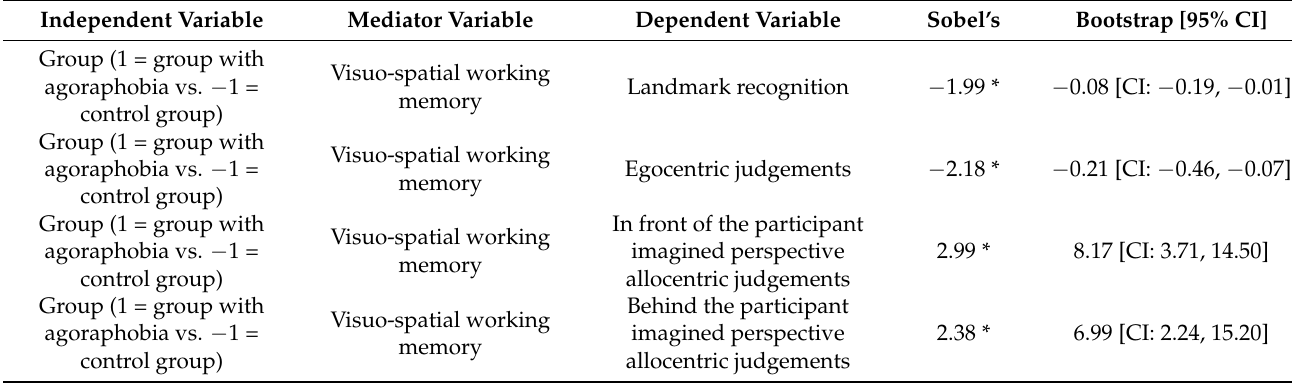
Table 1. Mediation analysis was carried out using the Preacher–Hayes bootstrapping method (Preacher and Hayes, 2004). Independent Variable Mediator Variable Dependent Variable Sobel’s Bootstrap [95% CI] Landmark